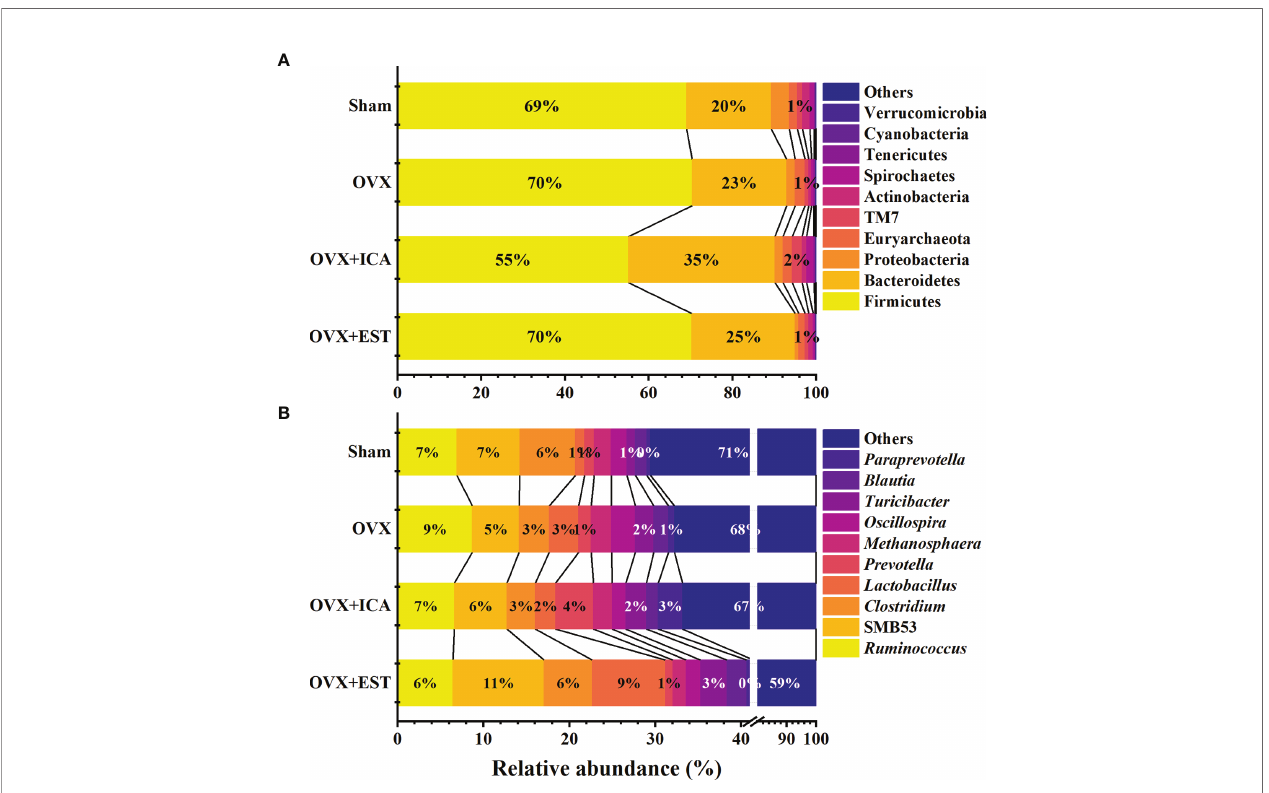
FIGURE 4 | Therapeutic effects of different treatments on the relative abundance of GM at the taxonomic levels of phylum (A) and genus (B) (n = 10). Only the Latin manes of the top 10 GM were given, while the low abundant ones were put together and shown as ‘‘ Others ’’ .